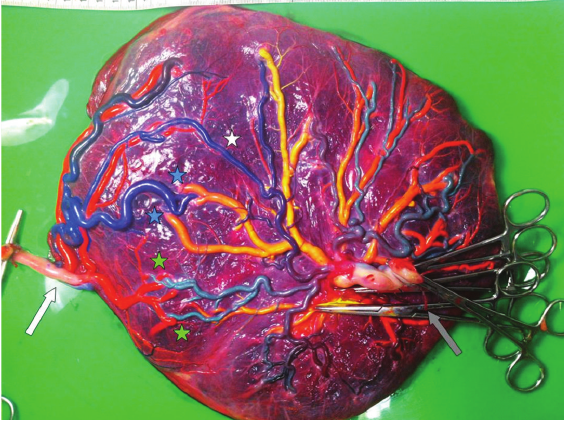
Figure 3: Monochorionic placenta after color dye injection (blue and green colors for arteries, red and yellow colors for veins) showing typical features of unequal sharing. Twin B has a velamentous cord insertion (white arrow) and a small placental territory (placental share on the left side of the picture). Twin A has a paracentral cord insertion (grey arrow) and a larger placental territory (right side of the picture). The white star indicates a large arterio-arterial anastomosis, the blue stars and green stars indicate several arterio-venous en veno-arterial anastomoses,